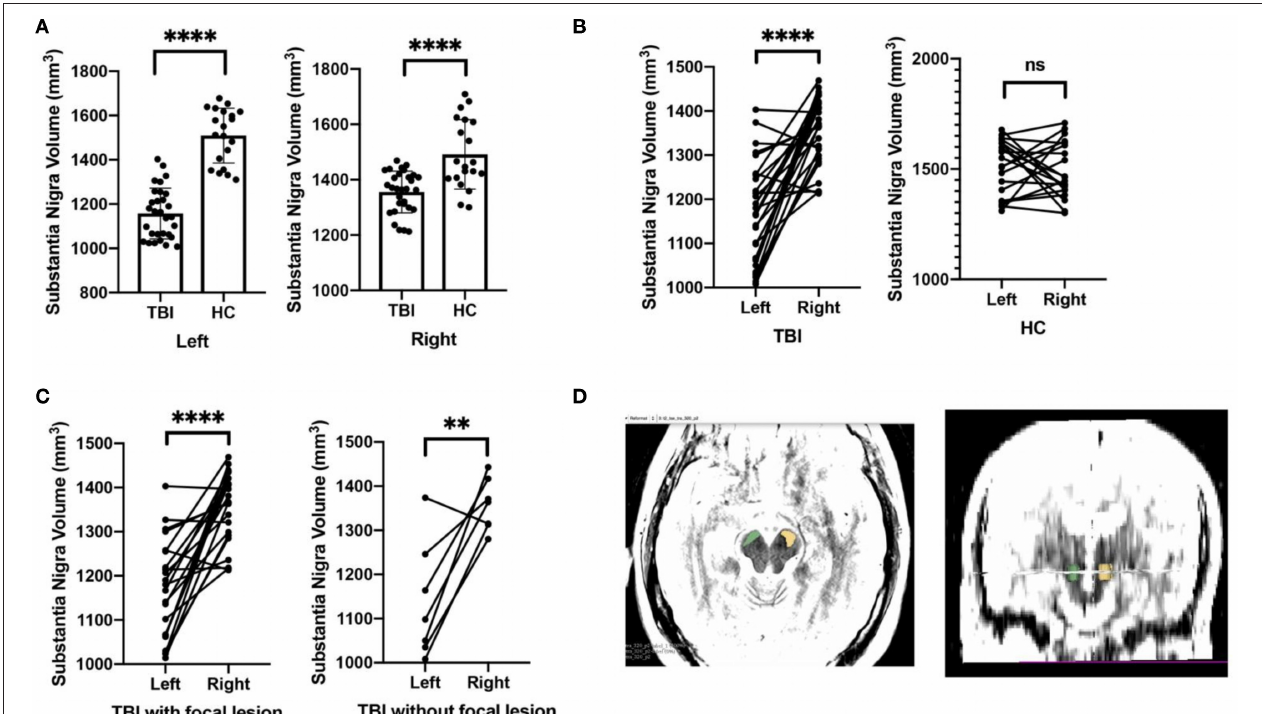
FIGURE 2 | Comparisons on the substantia nigra volume between TBI patients and healthy controls. (A) Relative to healthy controls, TBI patients had smaller substantia nigra in both right and left sides. (B) For TBI patients, the left substantia nigra was relatively small in contrast with the right one. (C) The volume difference between right and left substantia nigra was shown in all types of TBI participants, with and without focal brain injury. (D) The example of the hand-drawn substantia nigra on T2-weighted MRI was demonstrated. Green, right substantia nigra; yellow, left substantia nigra. **** p < 0.0001, ** p < 0.01.